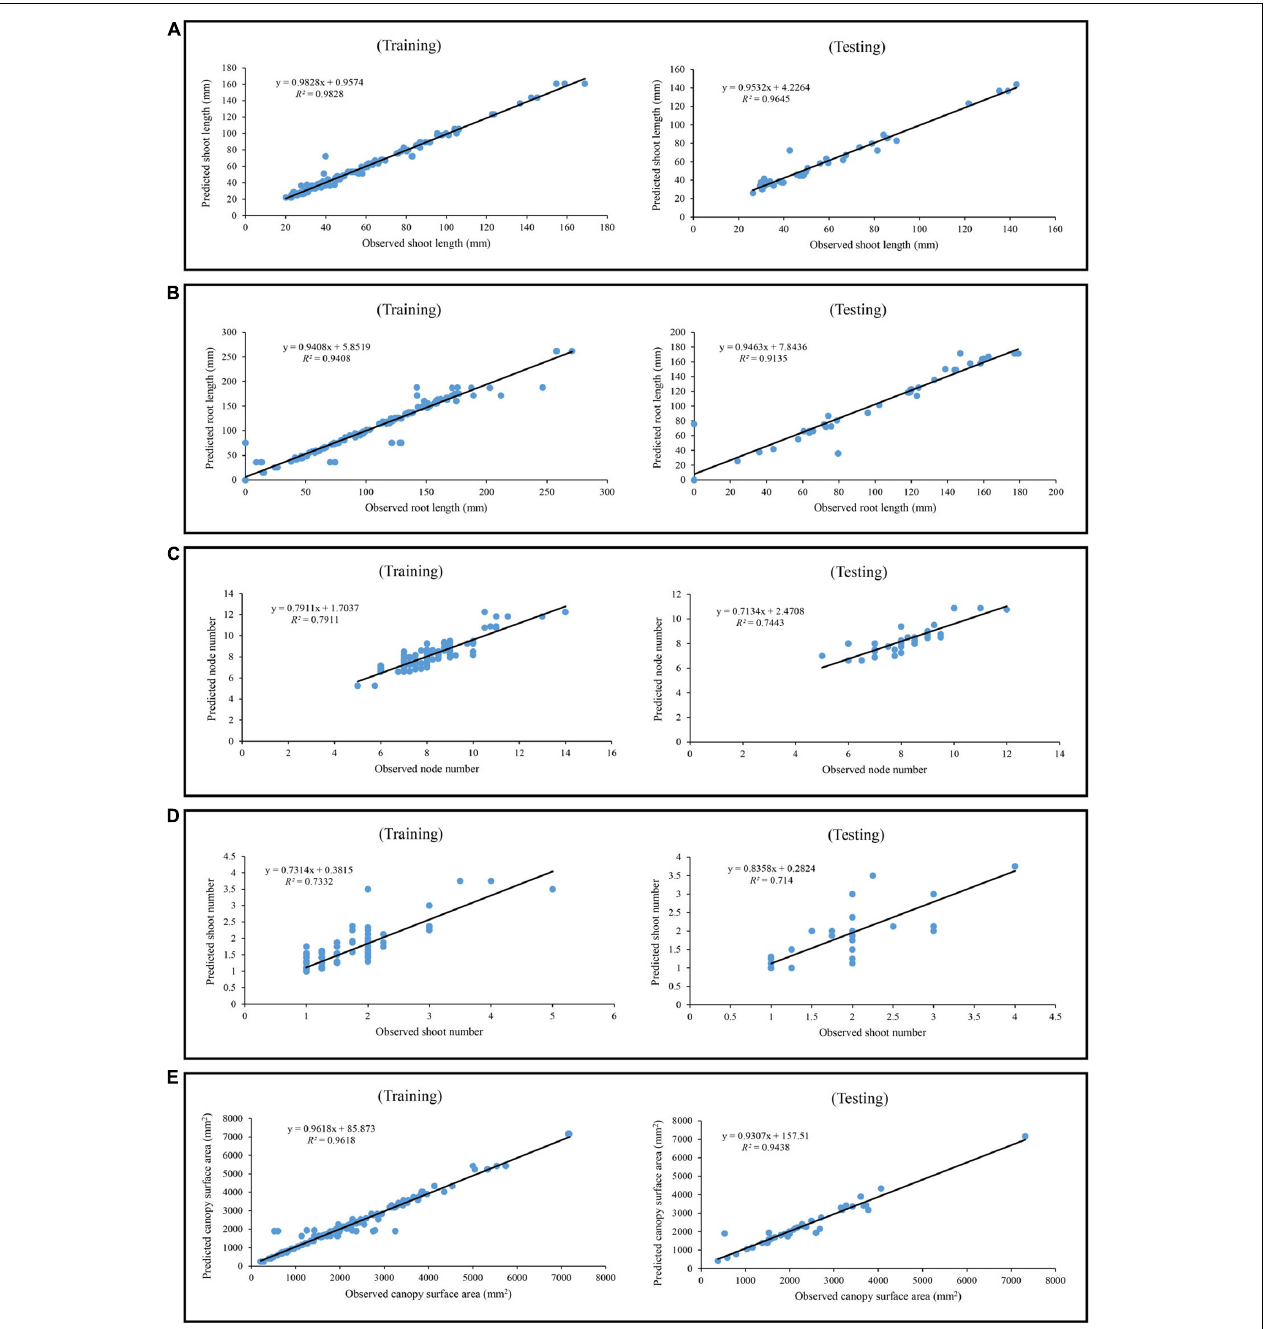
FIGURE 10 | Scatter plot of experimental data vs. predicted data of (A) shoot length, (B) root length, (C) node number, (D) shoot number, and (E) canopy surface area in in vitro Cannabis shoot growth and development, using generalized regression neural network (GRNN) in both training and testing